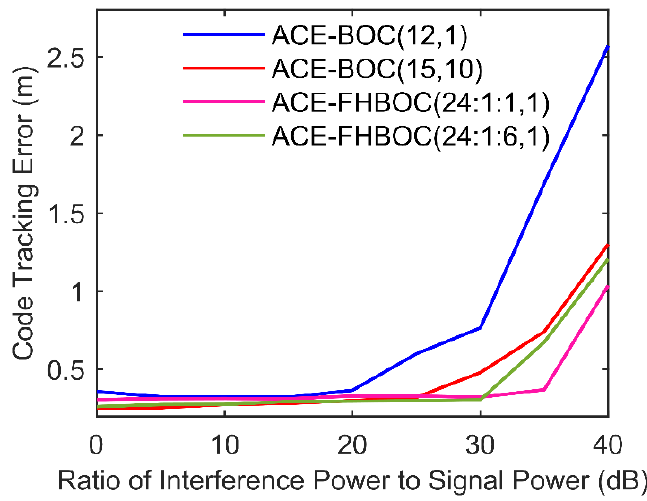
Figure 15. Tracking errors for the example signals.